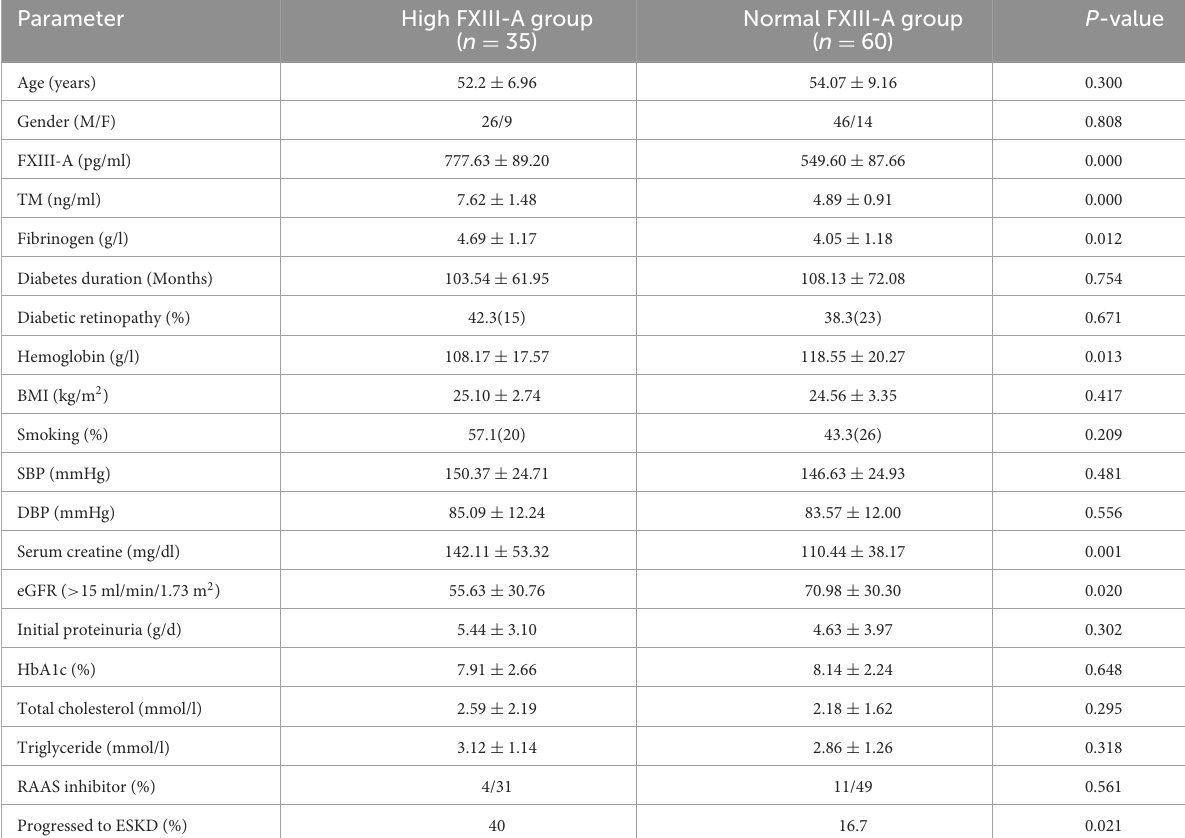
TABLE 1 Clinical features of DN patients with different serum FXIII-A levels at baseline.